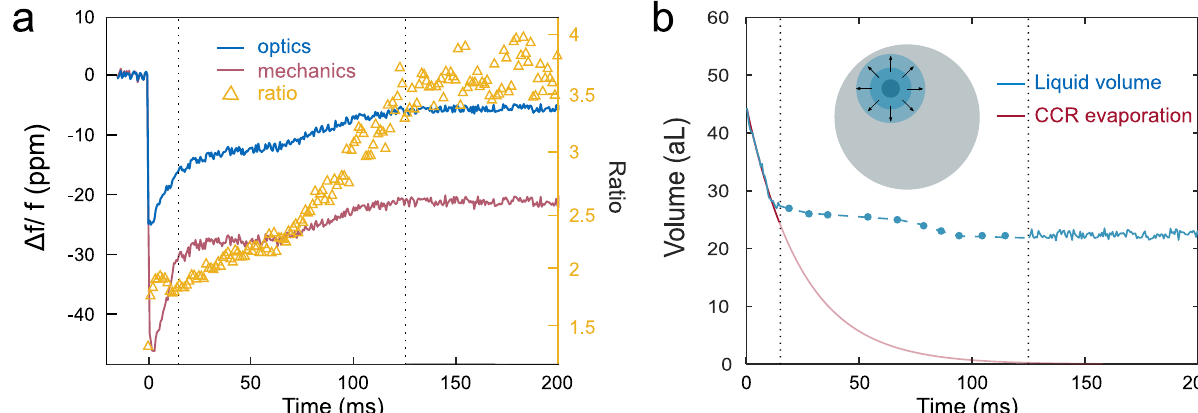
Fig. 5 | Optomechanical measurement of the transition from a nanodroplet to an extended fi lm. a Optical (blue) and mechanical (red) normalized resonance shift duringthe200msafterdropletlanding.The two signals do notreach backto their initial value at the end, indicating that a residual amount of liquid is still present on the disk surface. Their ratioisreportedwith yellowtriangles: itremains constant at 2 during the fi rst 5 ms, consistent with a localized droplet of spherical shape,andthenincreasesupto3.5,consistentwiththestabilizationofanextended